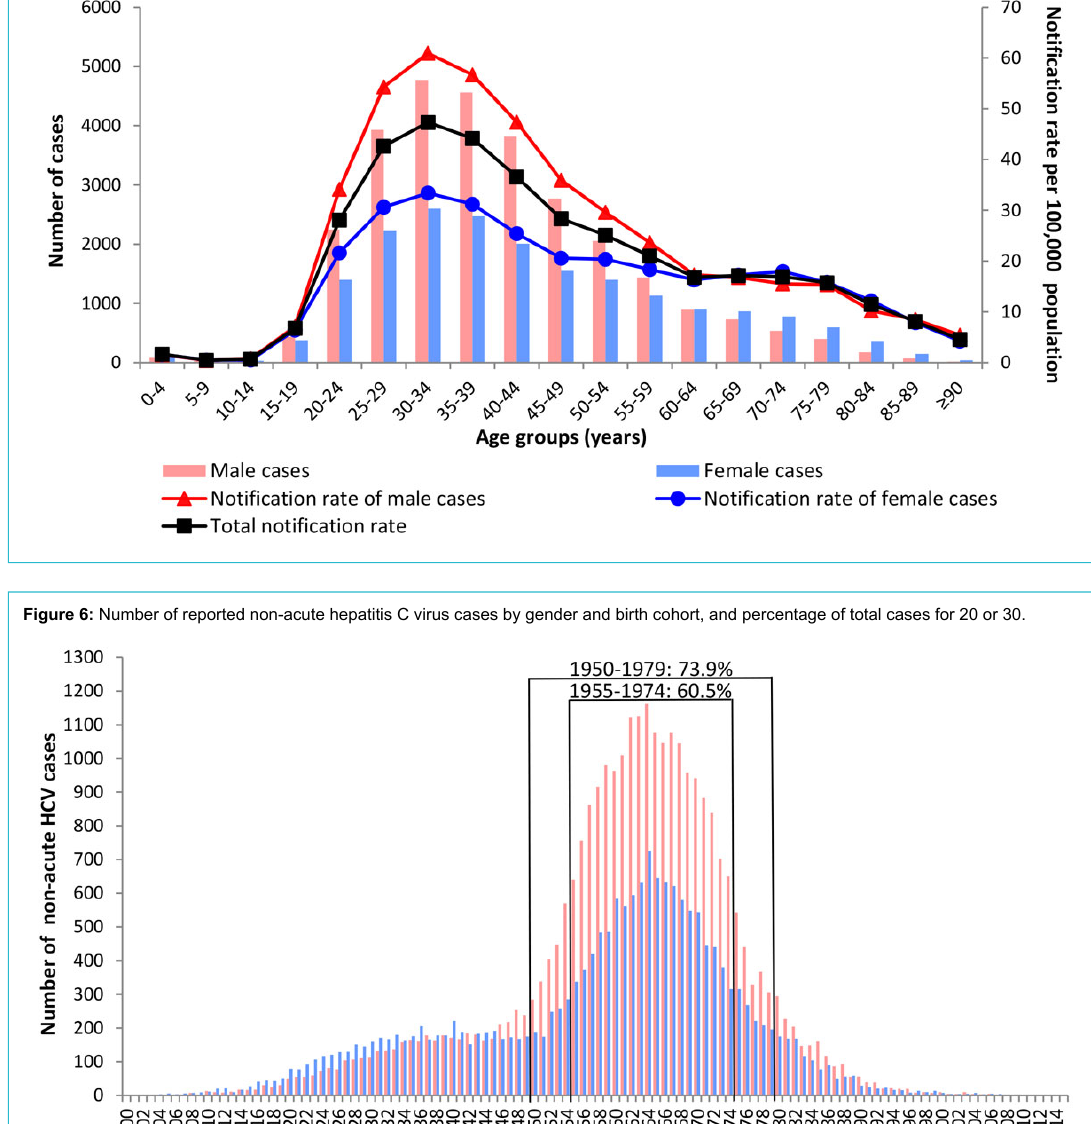
Figure 5: Numbers and notification rates of non-acute hepatitis C virus cases by gender and age group at time of the first notification.